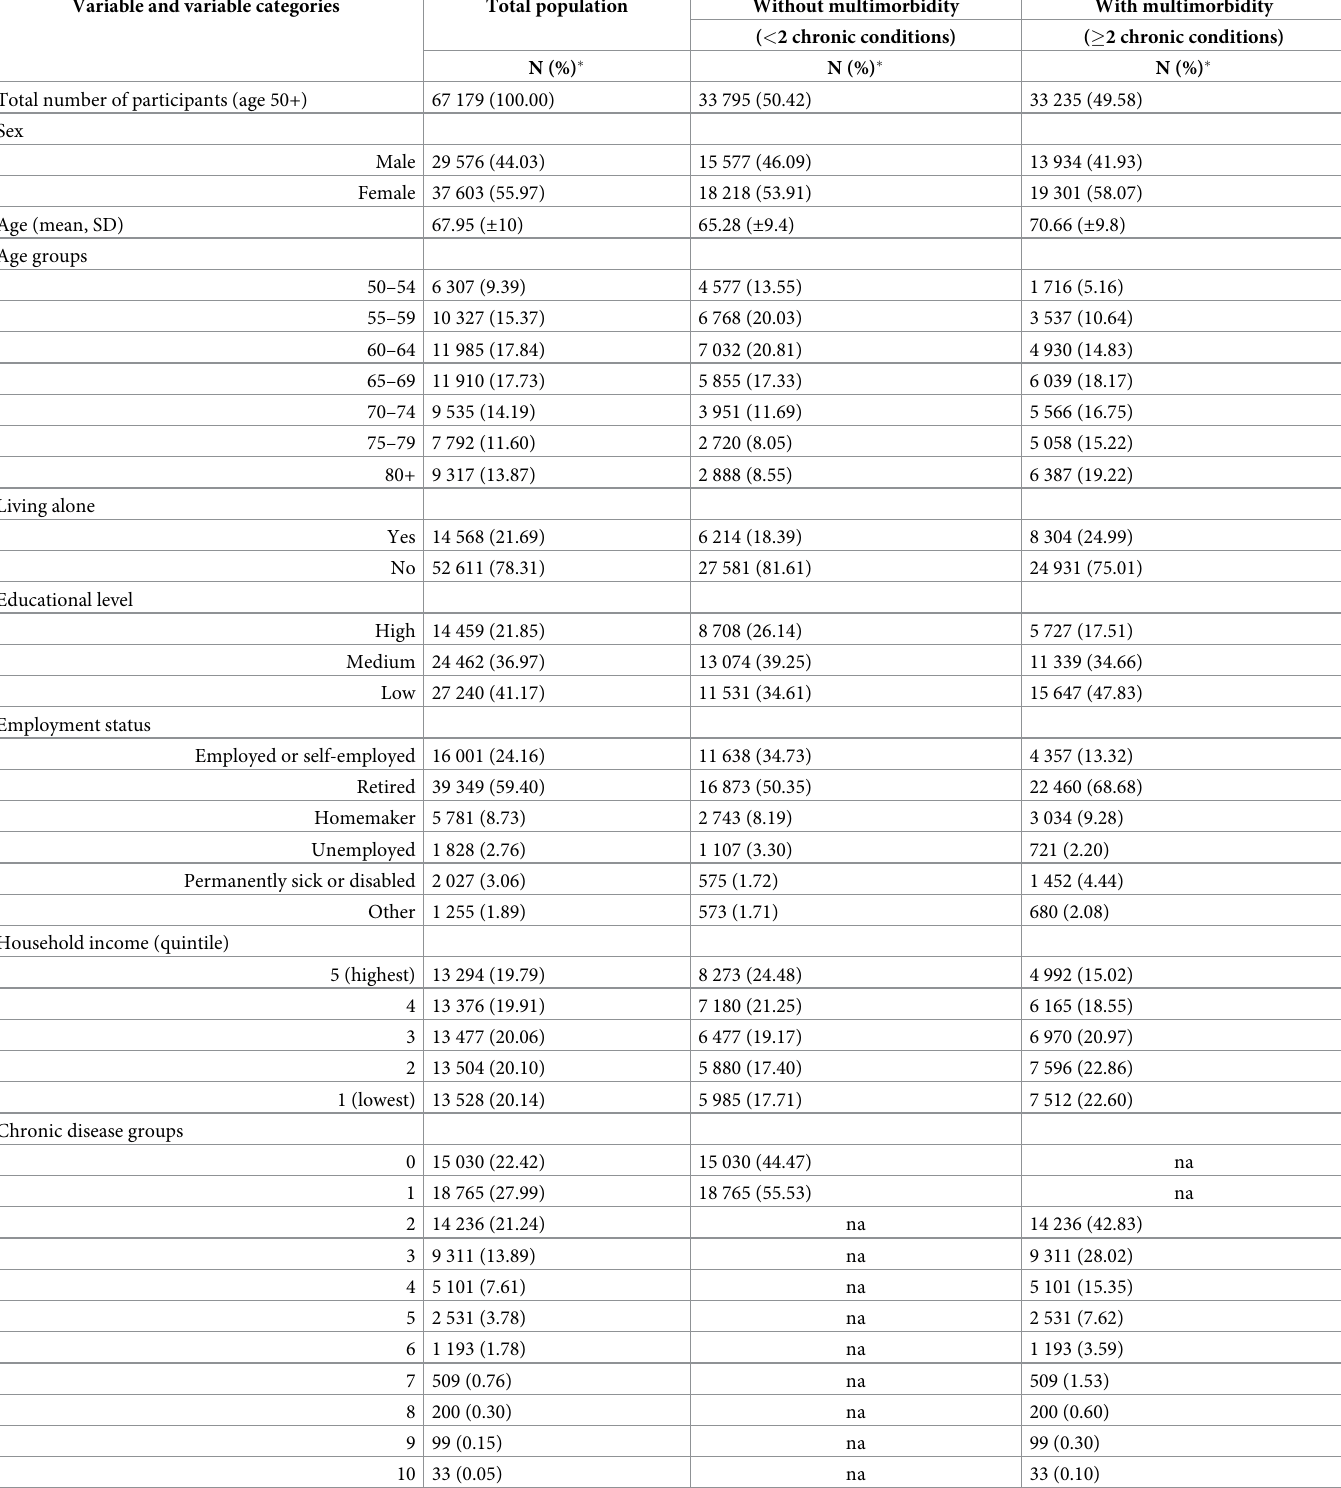
Table 2. Socio-economic characteristics of the study